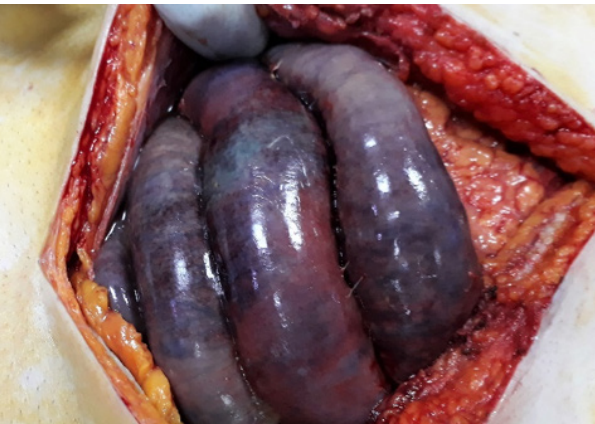
Figure 1: Gangrenous loops of small intestine seen following opening the abdomen.